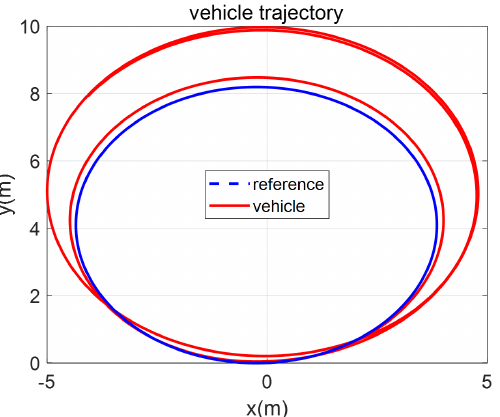
Figure 5. Vehicle trajectories in the steady-state cornering maneuver before and after fault occurrence.